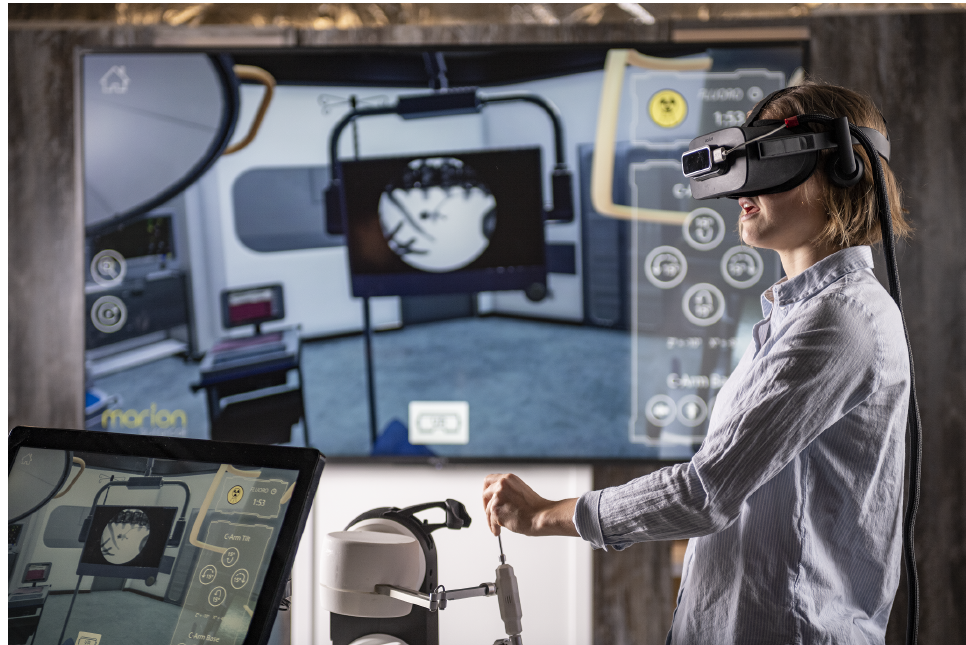
Figure 2. The virtual operating room of the Marion K181 PCNL simulator is shown with a user operating the haptic device, a virtual patient undergoing PCNL, virtual X-ray imaging, and the medical instruments and imaging device, which would be present in the real world operating room. The user is wearing a VR headset with the leap motion attachment for hand tracking. The TV screen behind the user shows a representation of what the user sees in VR, the X-ray view and the Virtual Reality Operating room. The user’s hands are holding the needle tool that is attached to the haptic robots that provide real-time force